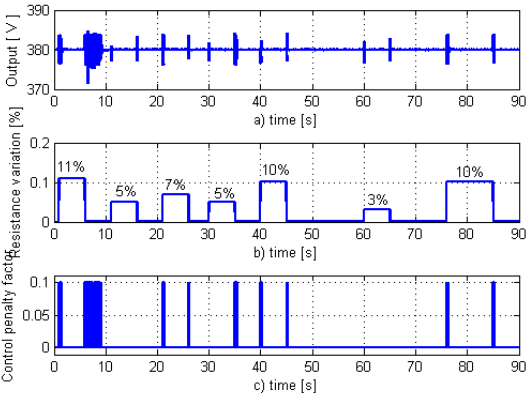
Figure 9. Robustness test—electrical load / unload: ( a ) controlled output (terminal voltage); ( b ) electrical resistance variation (disturbance); ( c ) variable setting of control penalty factor.